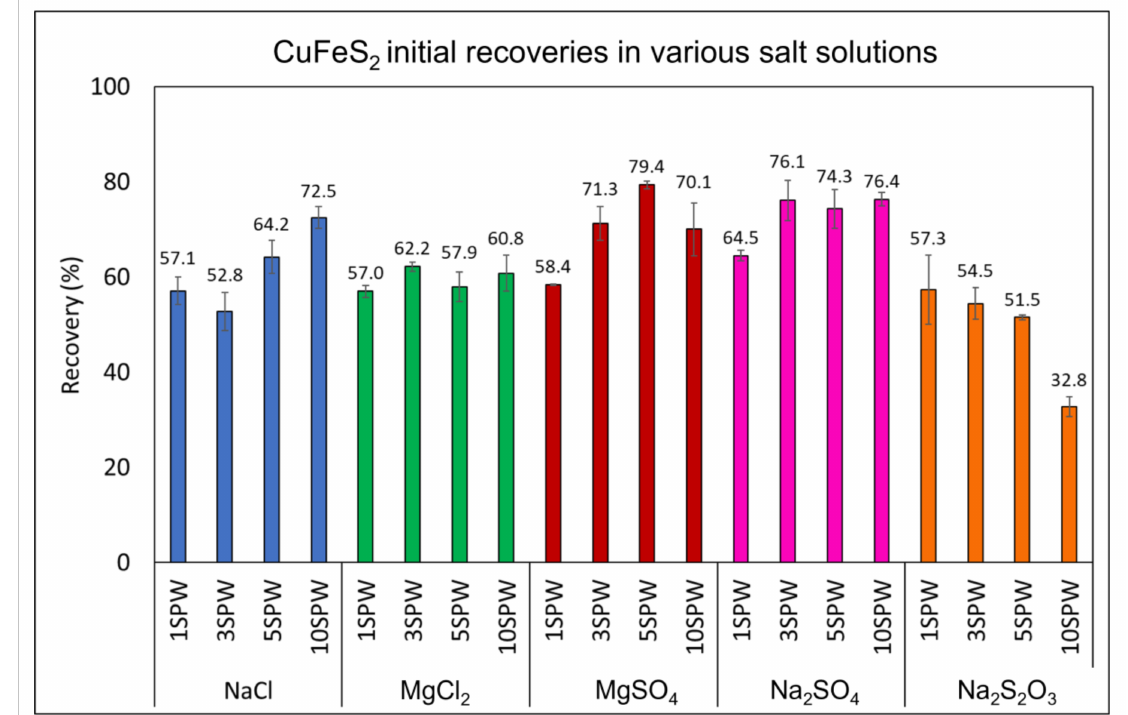
Figure 3. CuFeS 2 1st concentrate recovery in single salt solutions at varying ionic